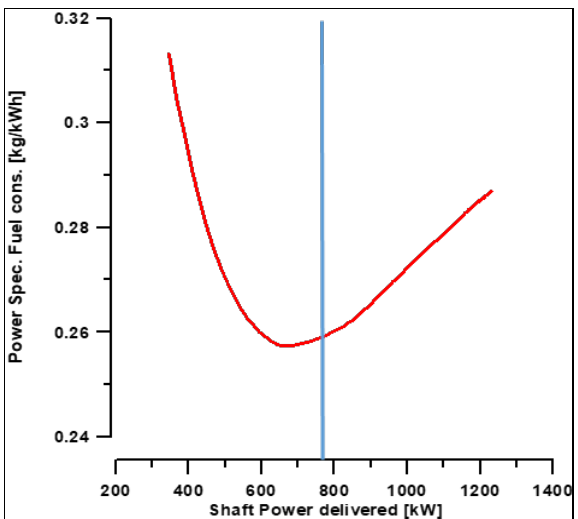
Figure 13. Specific fuel consumption vs power delivered at cruise altitude (5516 m). Engine_2.